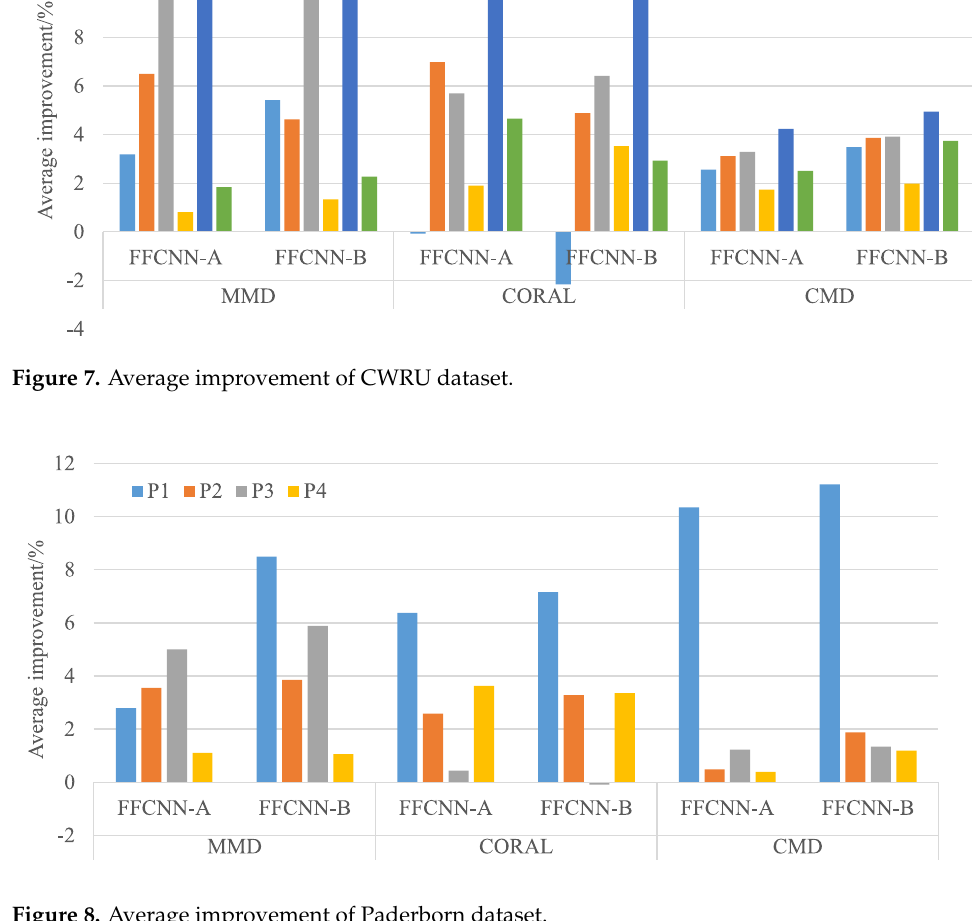
Figure 8. Average improvement of Paderborn